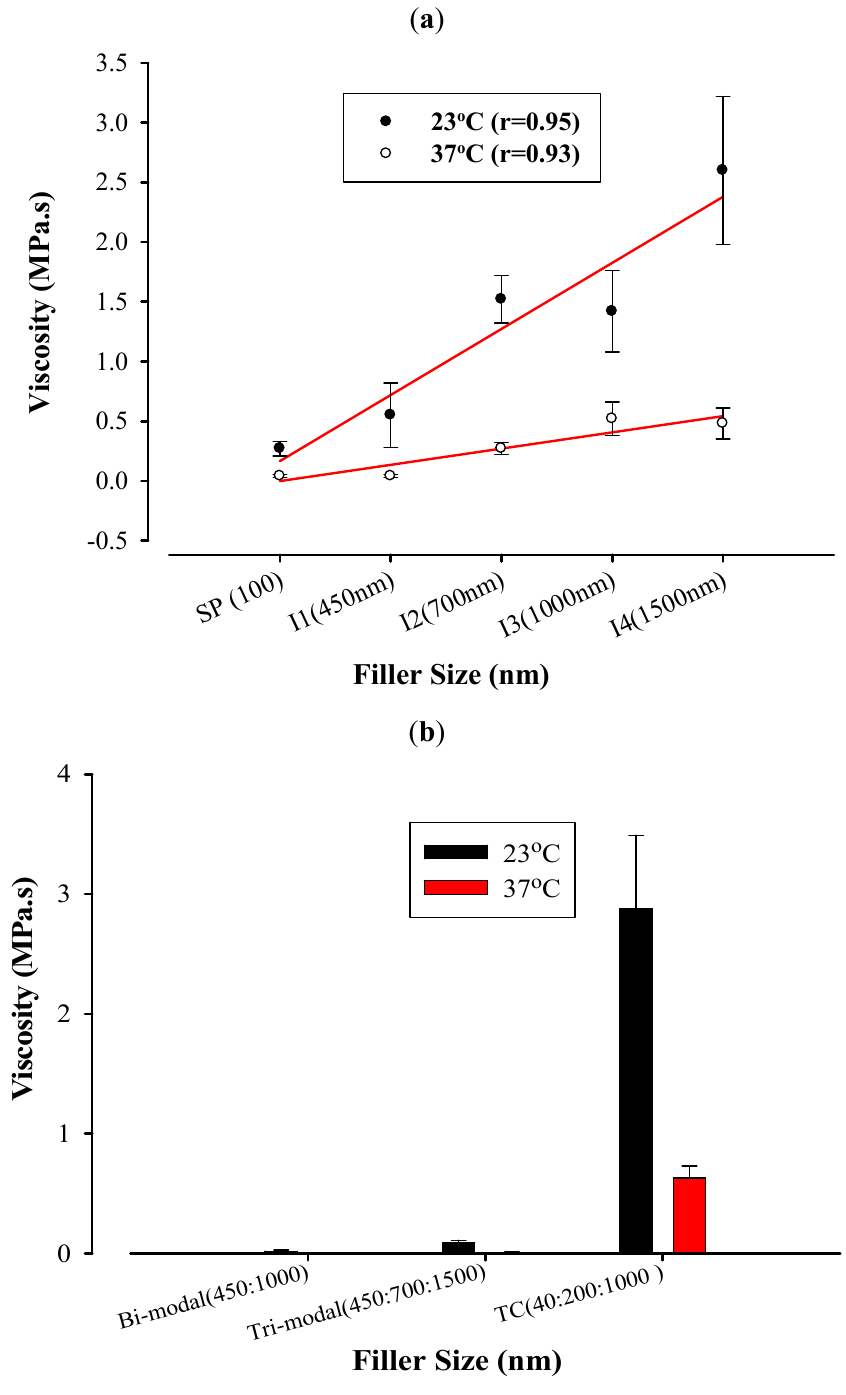
Figure 3. Effect of varying filler sizes at 23 °C and 37 °C on viscosity (MPa.s): ( a ) Linear correlations between viscosity (MPa.s) and unimodal composites at 23 °C and 37 °C; and ( b ) Bar Chart of viscosity (MPa.s) at 23 °C and 37 °C for multimodal